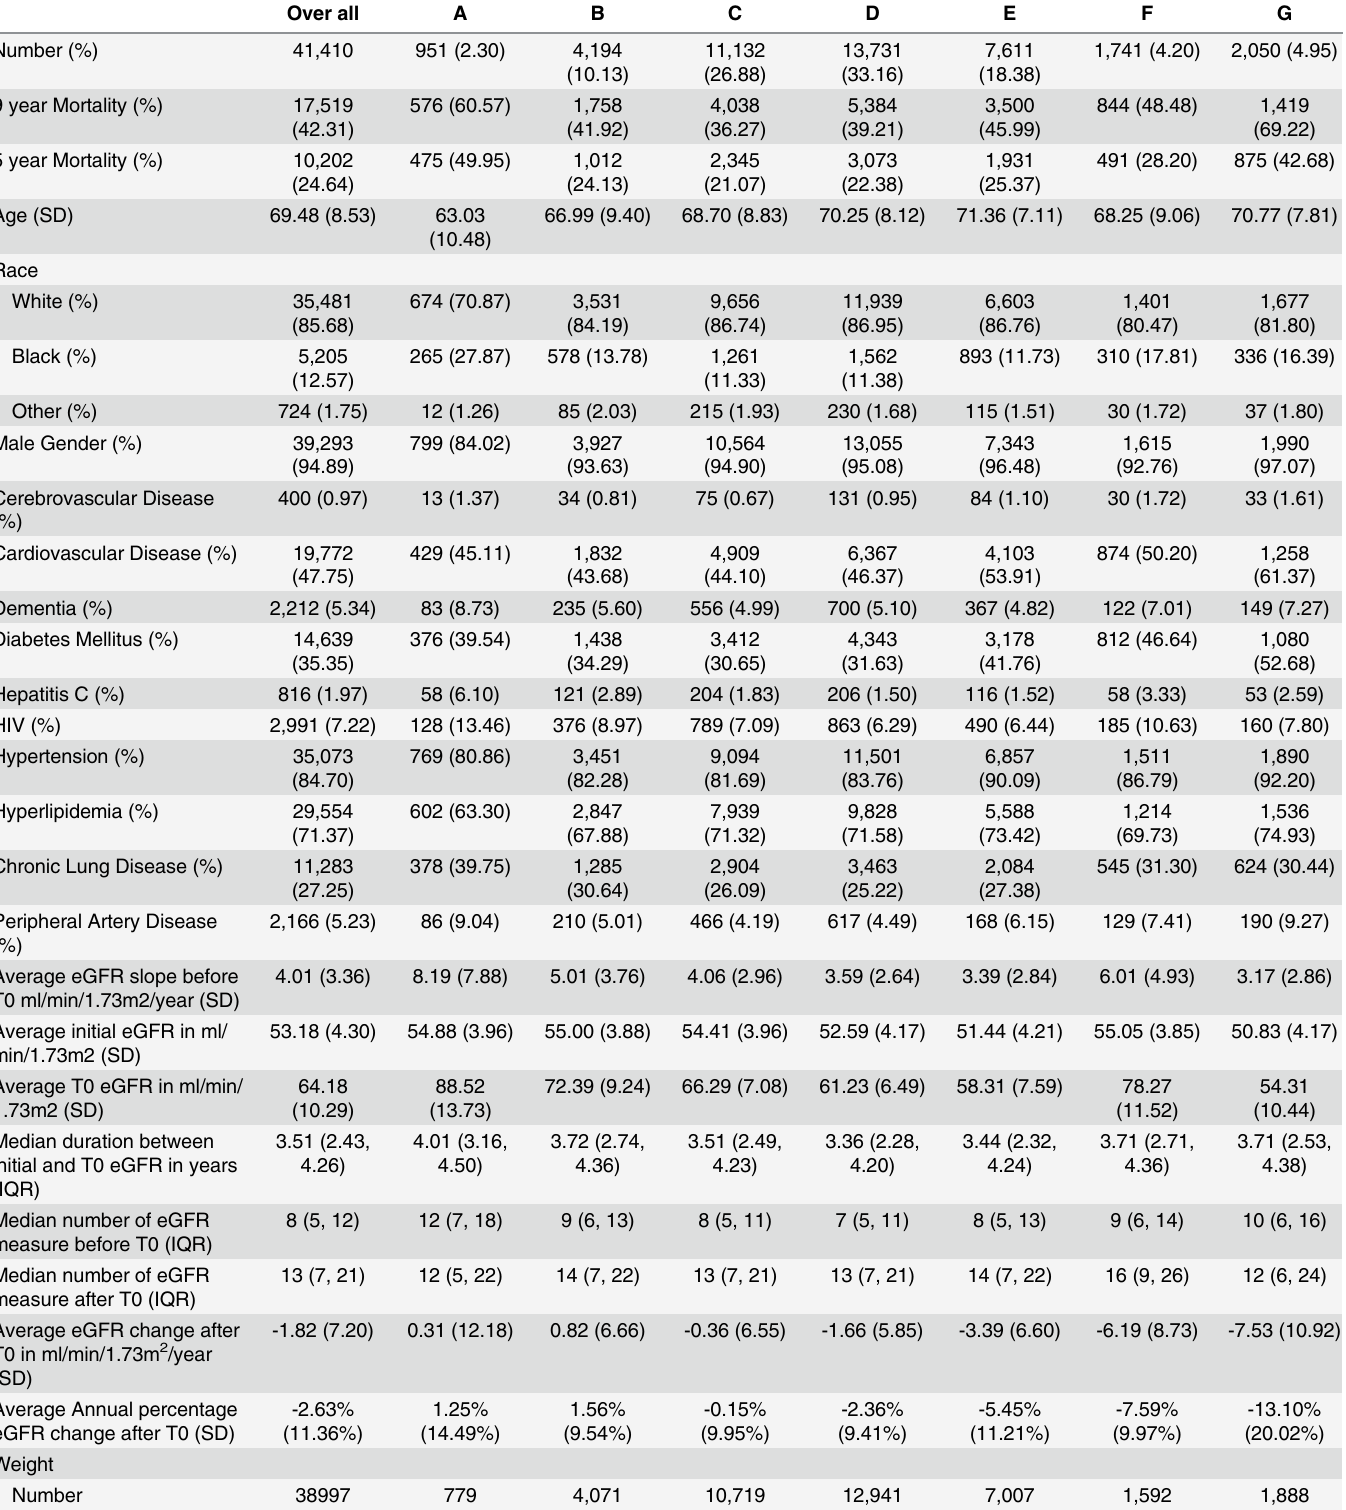
Table 4. Demographic and clinical characteristics according to renal function trajectory. Over